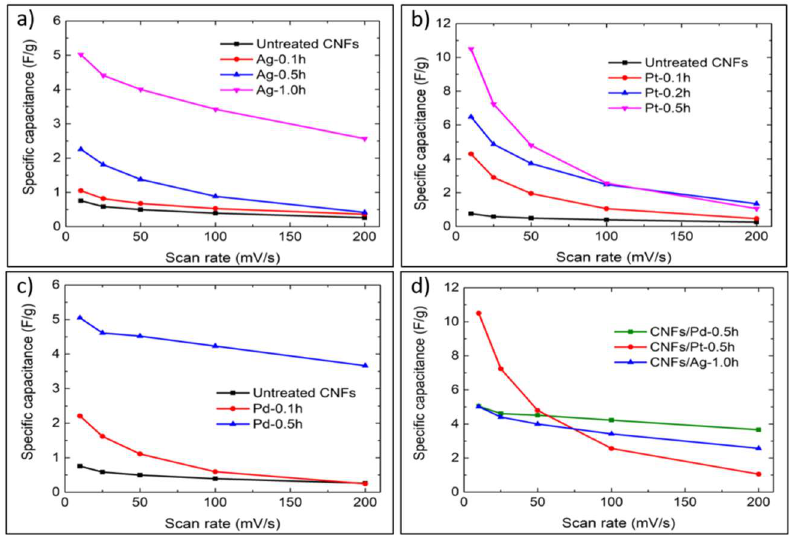
Figure 5. Specific capacitances for: ( a ) CNFs/Ag series; ( b ) CNFs/Pt series; ( c ) CNFs/Pd series; ( d ) CNFs/Ag-1.0h, CNFs/Pt-0.5h and CNFs/Pd-0.5h, at a series of scan rates (10 to 200 mV/s).